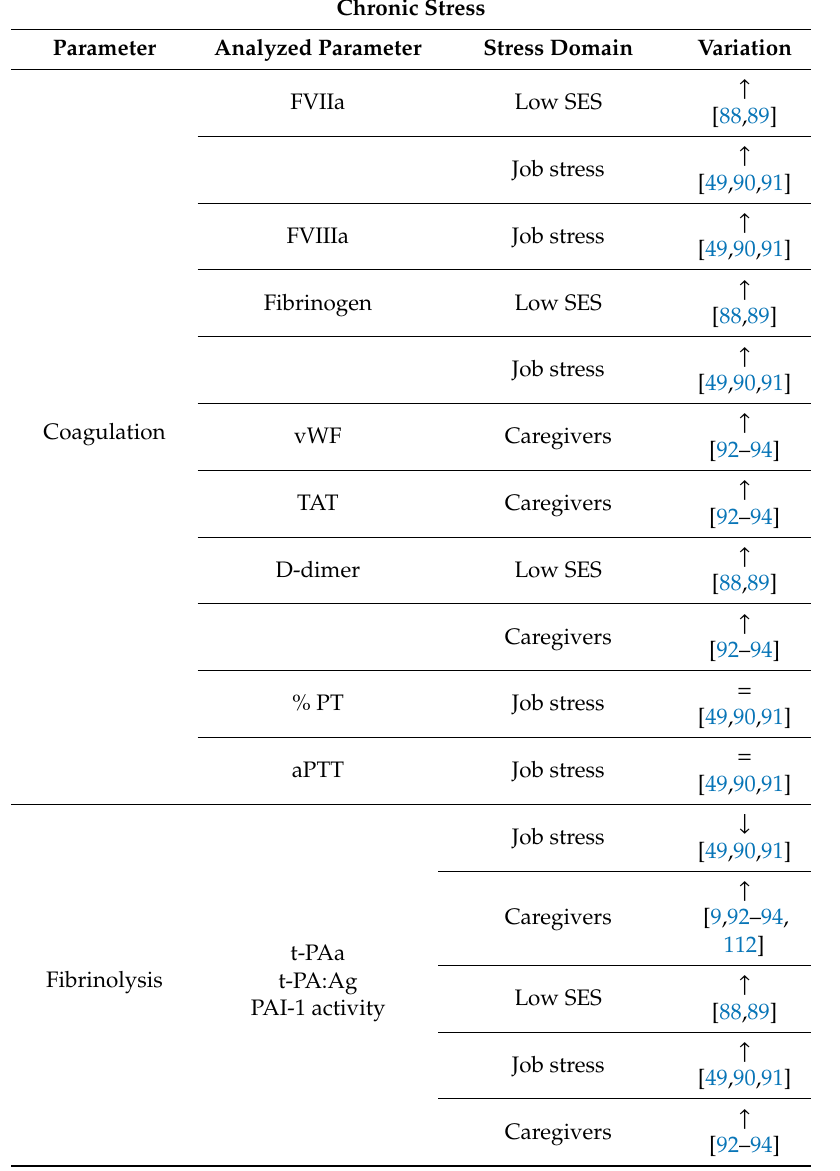
Table 3. Alteration of coagulation and fibrinolysis factors caused by chronic